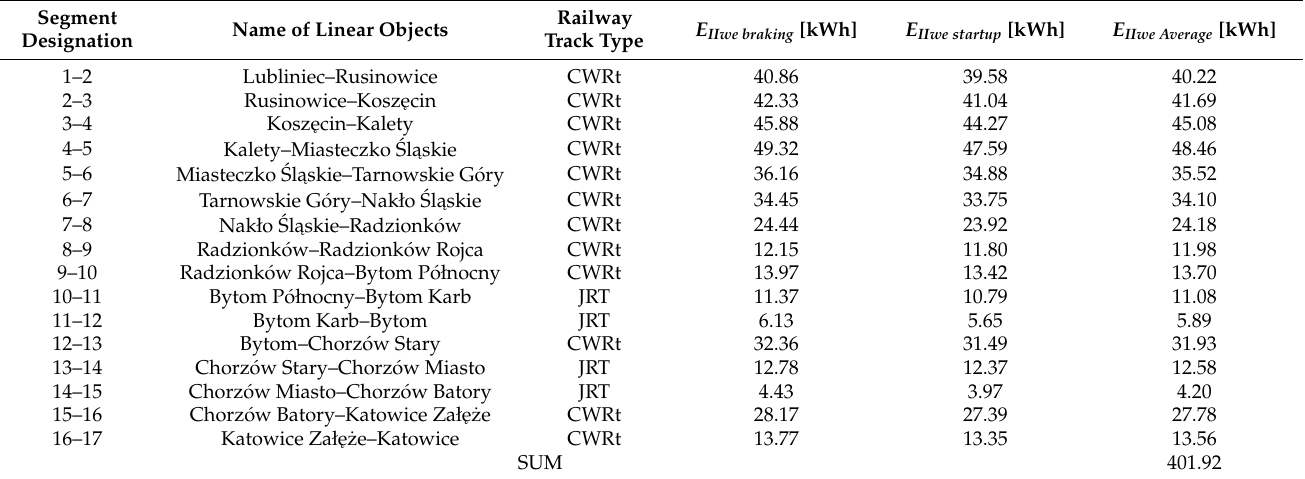
Table 9. Energy consumption depending on the type of railway